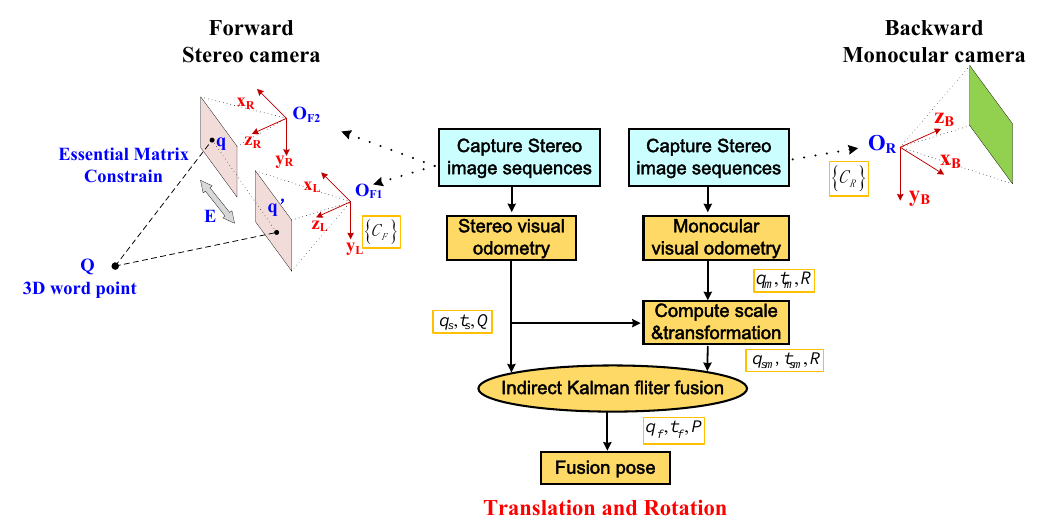
Figure 3. Framework of Loosely Coupled Forward and Backward Fusion Visual Odometry. [Color figure can be viewed at